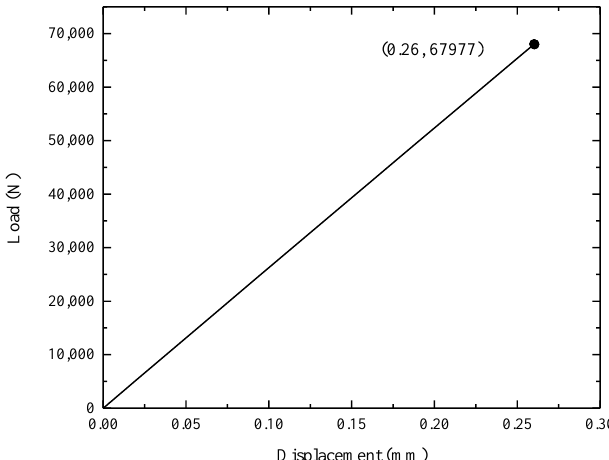
Figure 4. Load–displacement curve obtained by FEA. Figure 4. Load – displacement curve obtained by FEA. Figure 4. Load – displacement curve obtained by FEA.